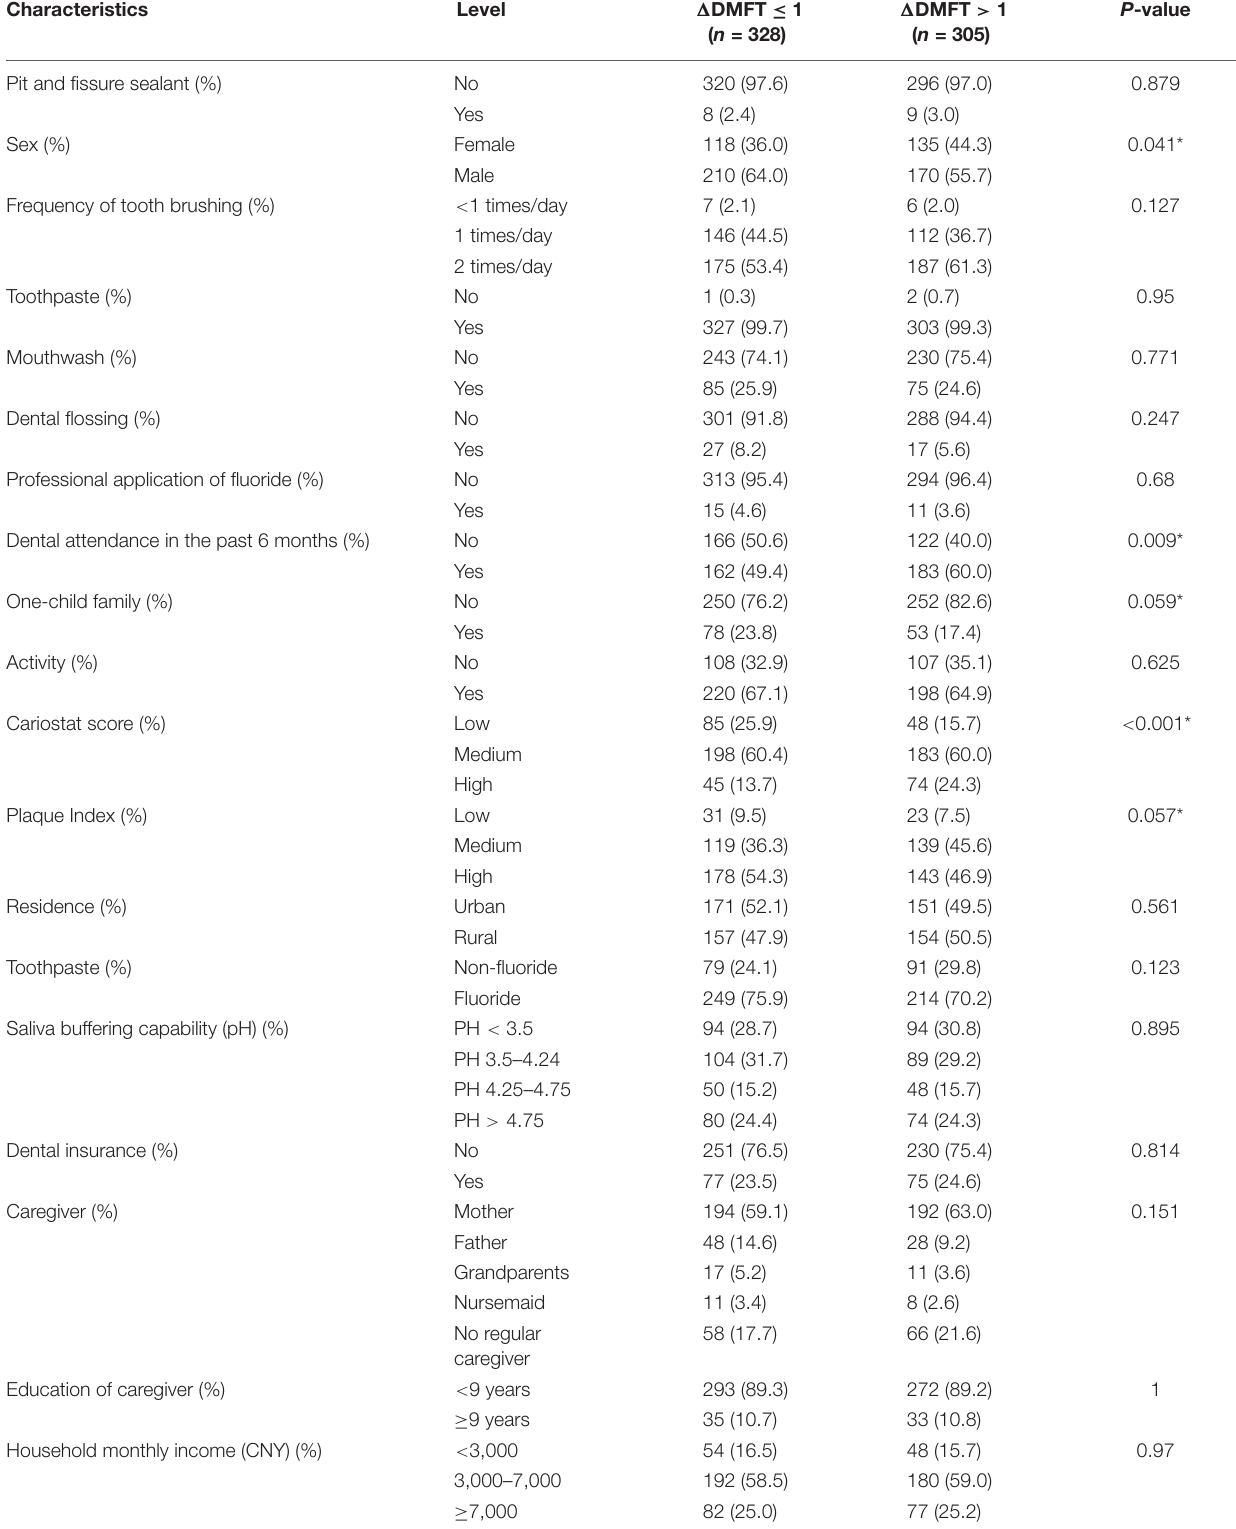
TABLE 2 | Logistic analysis of the association between environmental factors and caries.